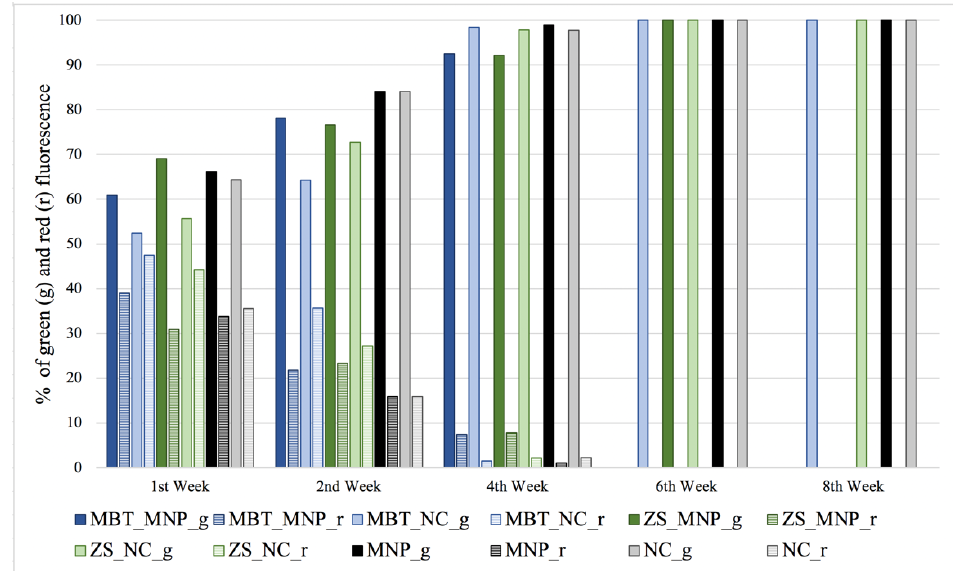
Figure 4. Comparative evaluation between the fluorescence of accessory pigments (green) and the chlorophyll (red) of the nanocontainers not loaded and loaded with biocides. The changing of the cells ’ fluorescence from red to green and the successive complete disappearance highlights the differential efficiency of products.